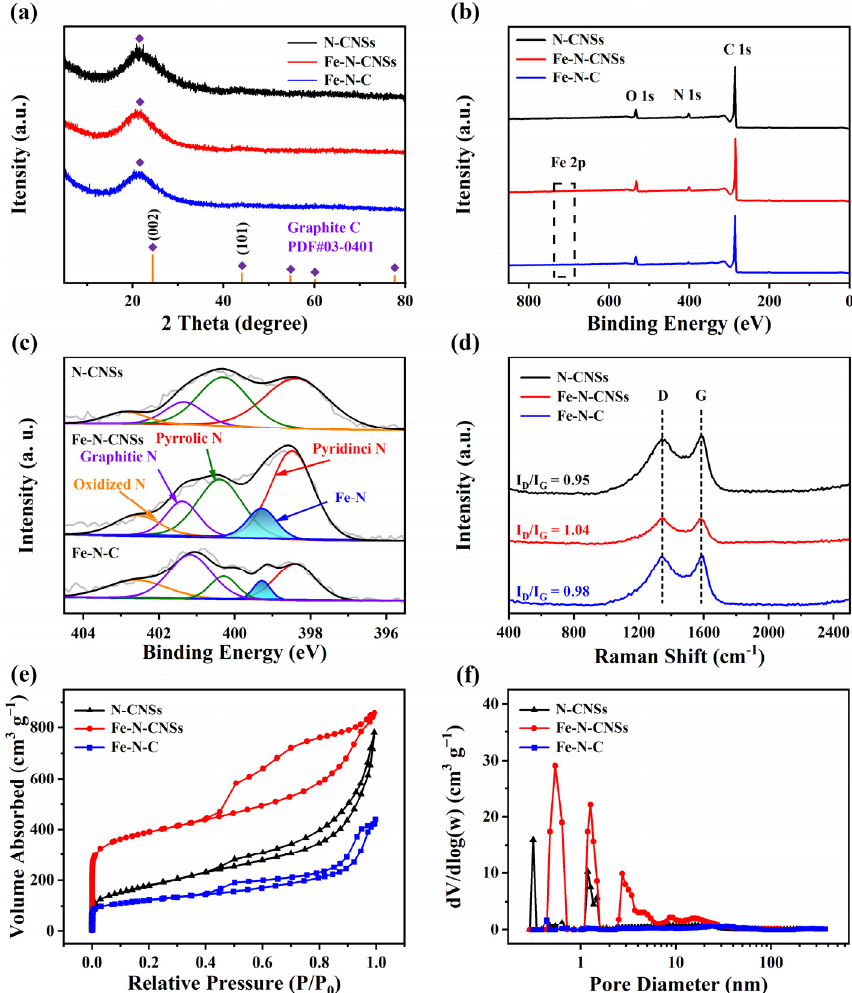
Figure 2. ( a ) XRD pa tt erns, ( b ) XPS surveys, ( c ) N 1s spectra, ( d ) Raman spectra, ( e ) The N 2 adsorp- tion-desorption isotherms and ( f ) the pore size distribution of N-CNSs, Fe-N-CNSs and Fe-N-C. Table 3. BET surface area and BJH pore volume for Fe-N-CNSs-x (x = 800, 900 and 1000), N-CNSs and